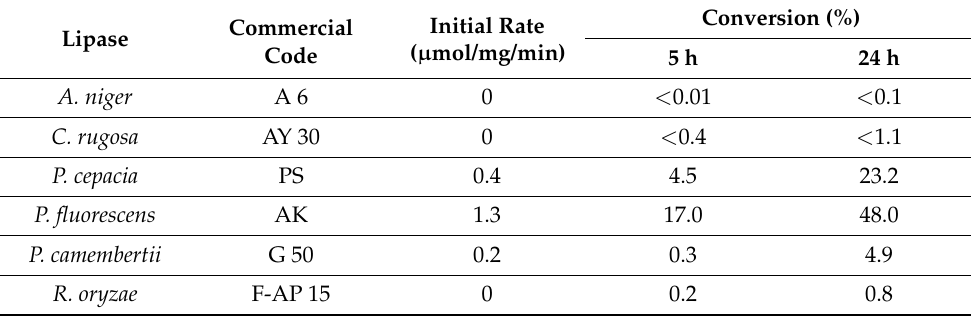
Table 7. Screening commercial crude lipases for alcoholysis of pure triolein with methanol in